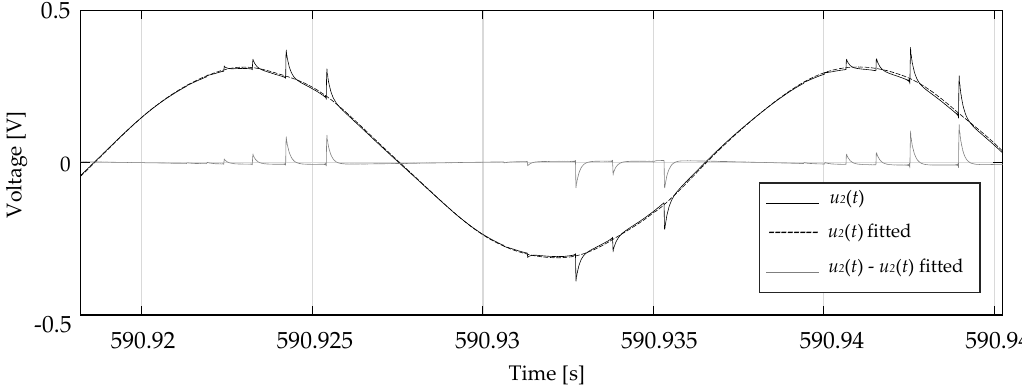
Figure 9 . The actual current as well as the discharge free current from the regression calculation current during 1.5 periods of an experiment after the inception of an electrical tree.